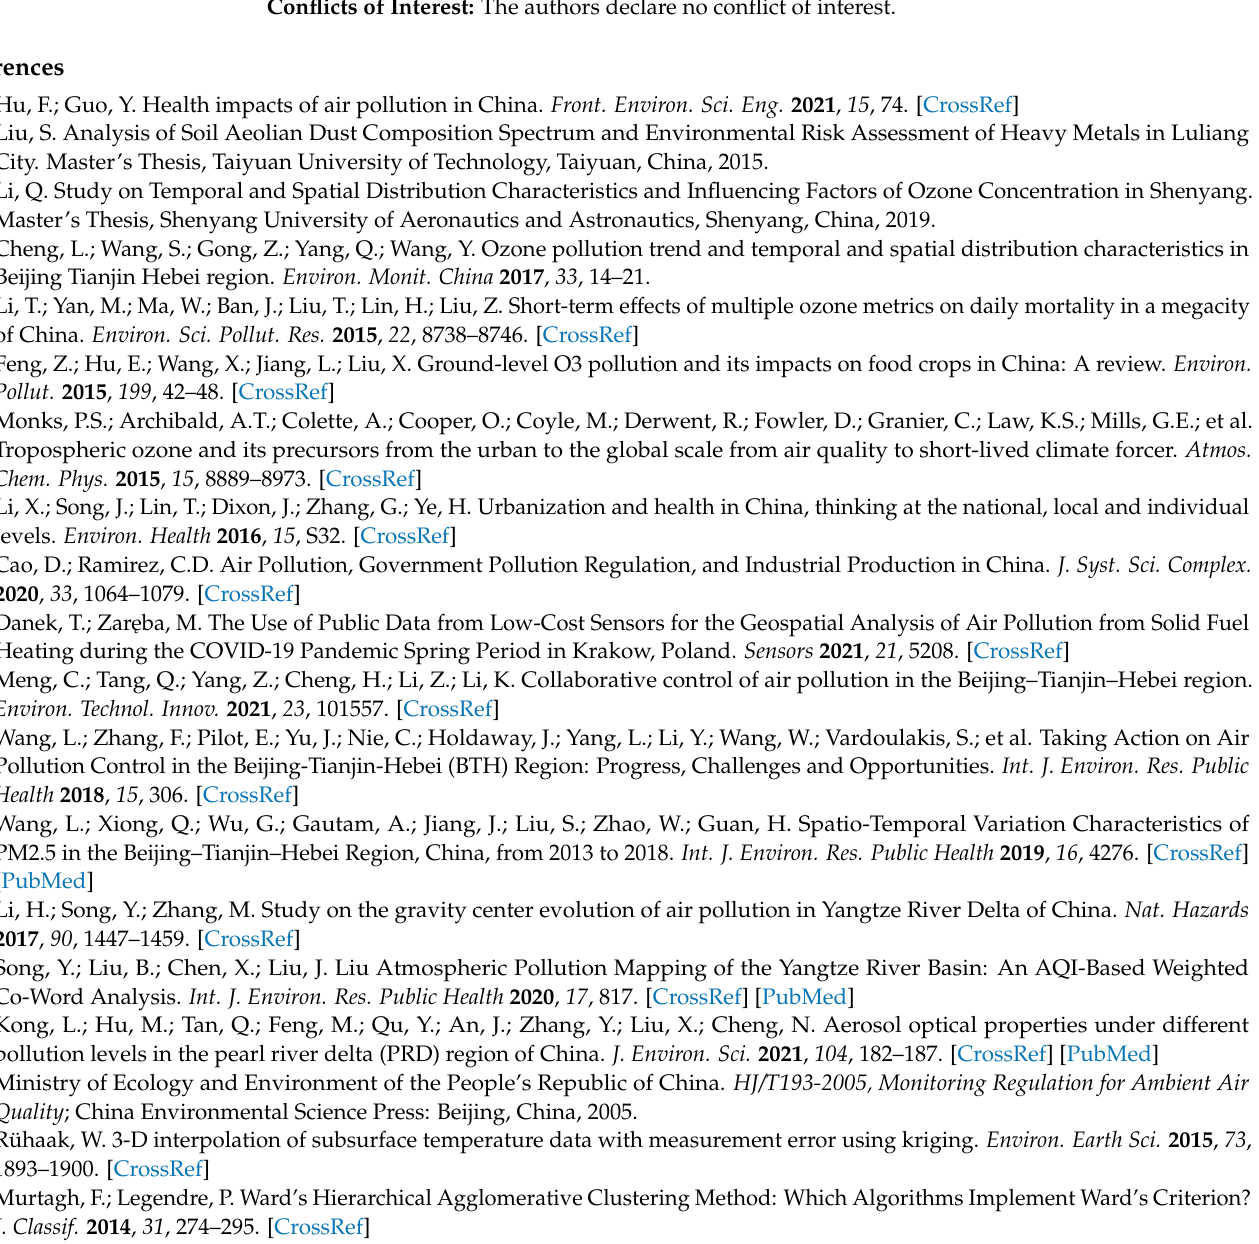
Table S2: Main economic activities in Eastern Jilin Province in